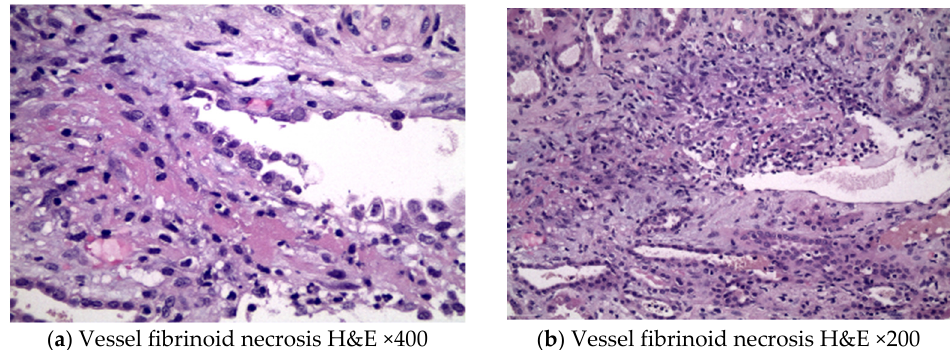
Figure 1. Fibrinoid necrosis in a parenchymal structure, most likely corresponding to a vessel wall. Although many sections were obtained, the exact vessel type cannot be clearly identified and determined (i.e., artery, vein, or lymph vessel), since it is entirely damaged (( a ) H&E × 400, ( b ) H&E × 200).